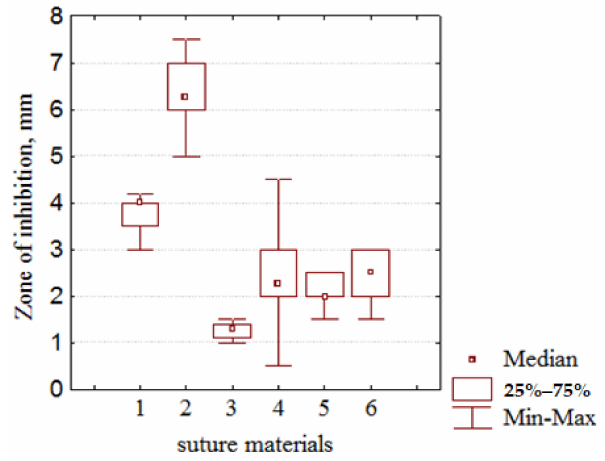
Figure 8. Changes in the antibacterial activity of the different fibers with AgNPs after cyclic freez- ing/thawing: 1: silk fibers with AgNPs and without cyclic freezing/thawing; 2: silk fibers with AgNPs and with cyclic freezing/thawing; 3: the catgut fibers with AgNPs and without cyclic freezing/thawing; 4: catgut fibers with AgNPs and with cyclic freezing/thawing; 5: perlon fibers with AgNPs and without cyclic freezing/thawing; 6: perlon fibers with AgNPs and with cyclic freezing/thawing.